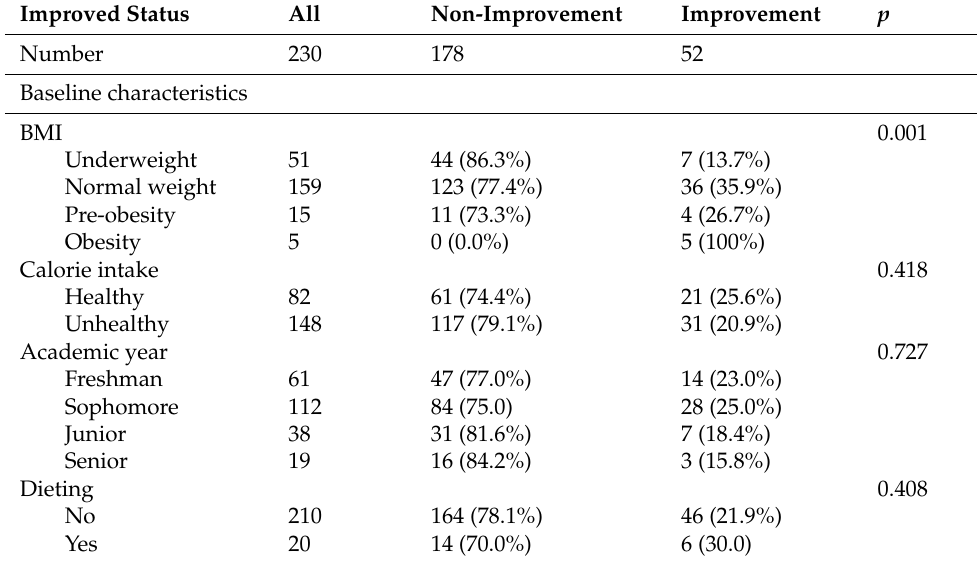
Table 6. Baseline characteristics of 230 students stratified by improvement and non-improvement of